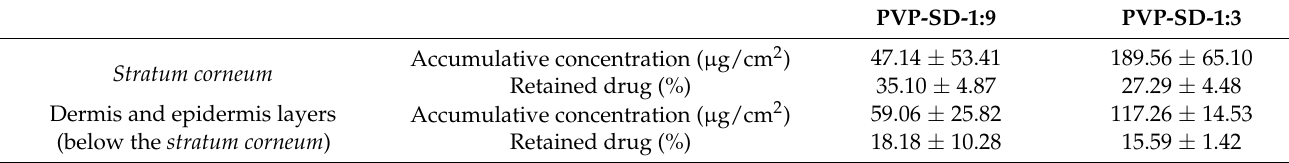
Table 6. Trans -resveratrol retention in skin layers after 24